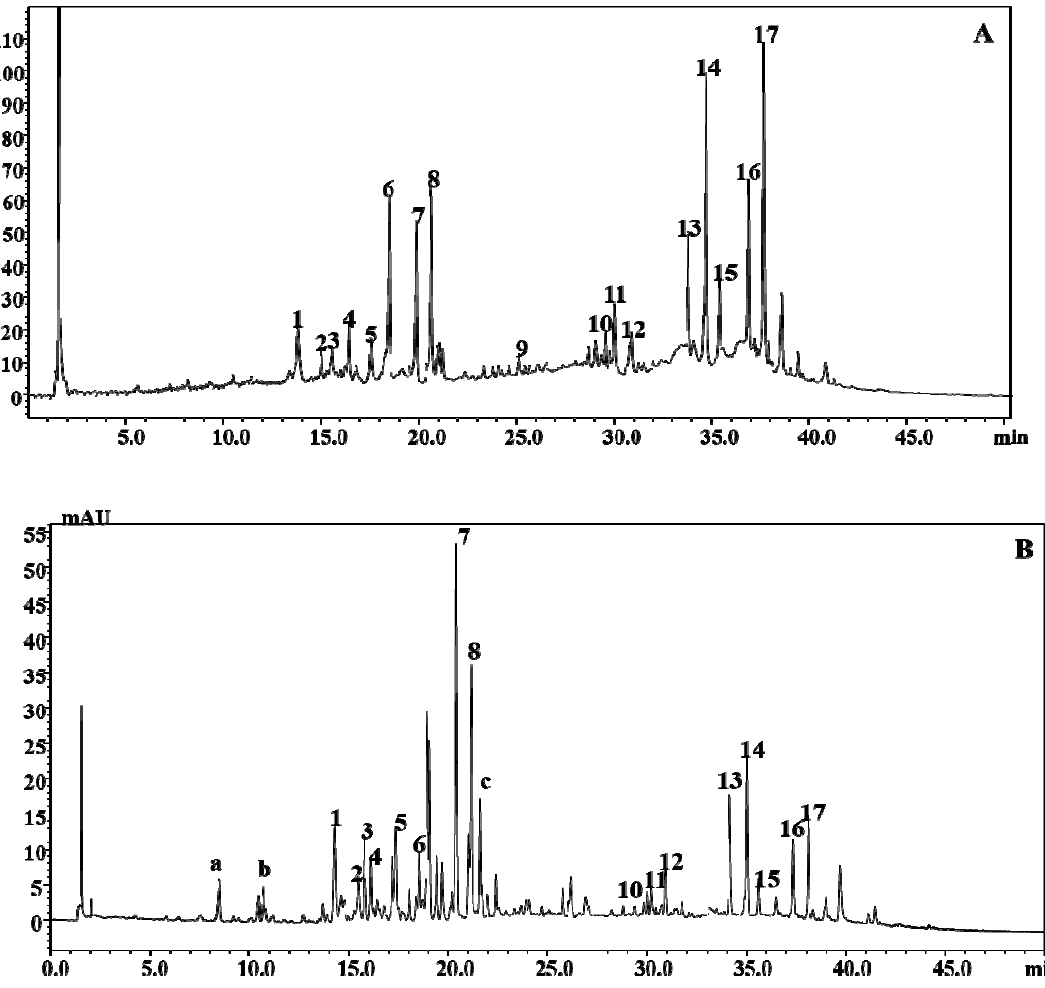
Figure 1. HPLC-PDA-ESI-MS polyphenolic fingerprint of B. incana leaf ( A ) and flowering top ( B ) hydroalcoholic extracts. Column: Ascentis Express C18, 15 cm × 4.6 mm, 2.7 µ m d.p. (ESI, negative ionization mode). For peak identification, see Table